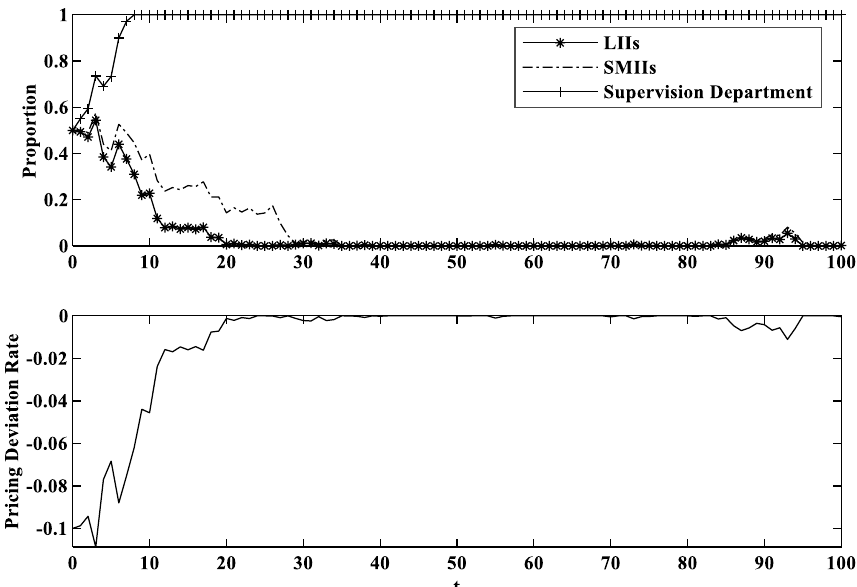
Fig. 3 strategy evolution and market performance under scenario